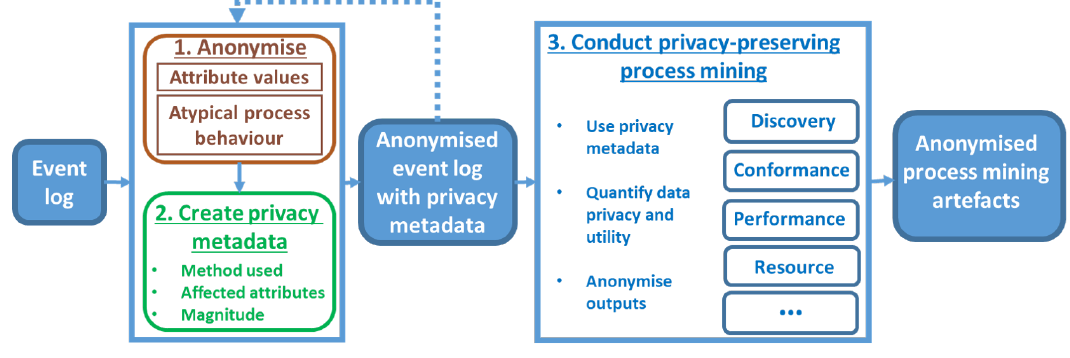
Figure 11. Privacy-preserving process mining